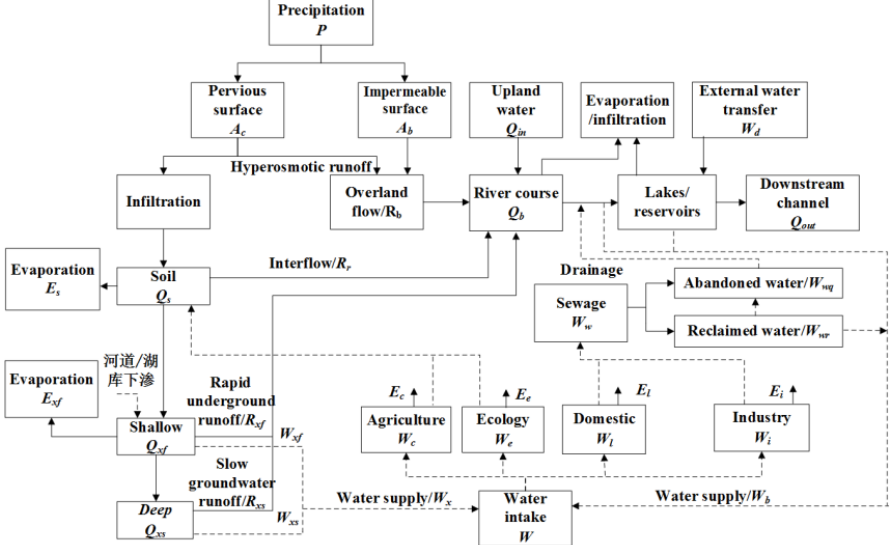
Figure 6. The structural framework of the GWAS model.